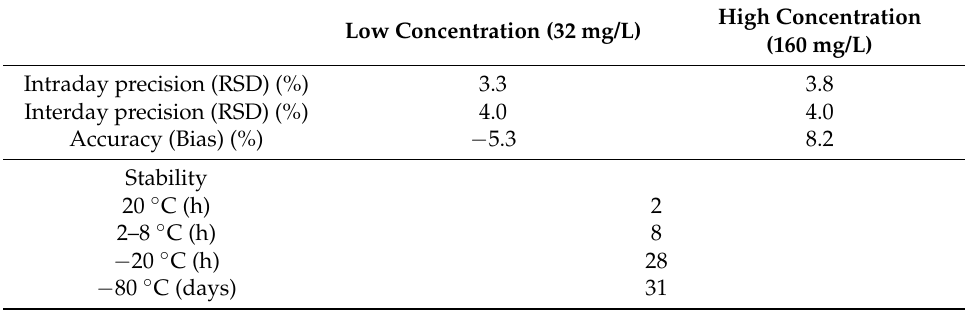
Table 1. Results of the HPLC-UV validation for cefiderocol in serum .